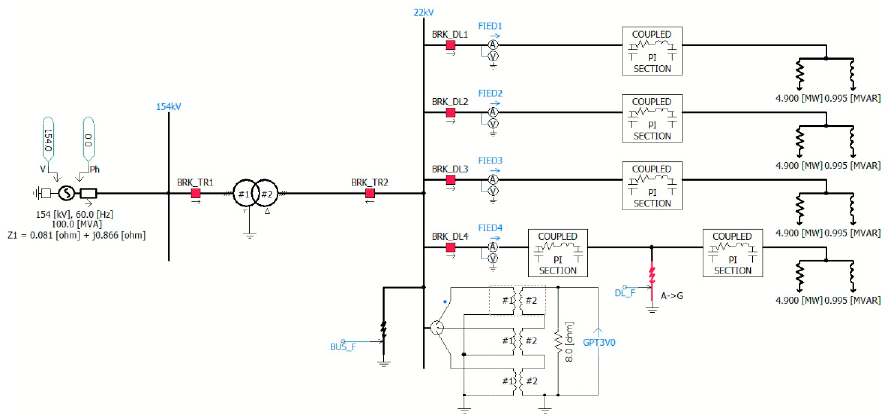
Figure 9. Power System Computer Aided Design / Electro-Magnetic Transient Design and Control (PSCAD/EMTDC) modeling of the ungrounded distribution system.